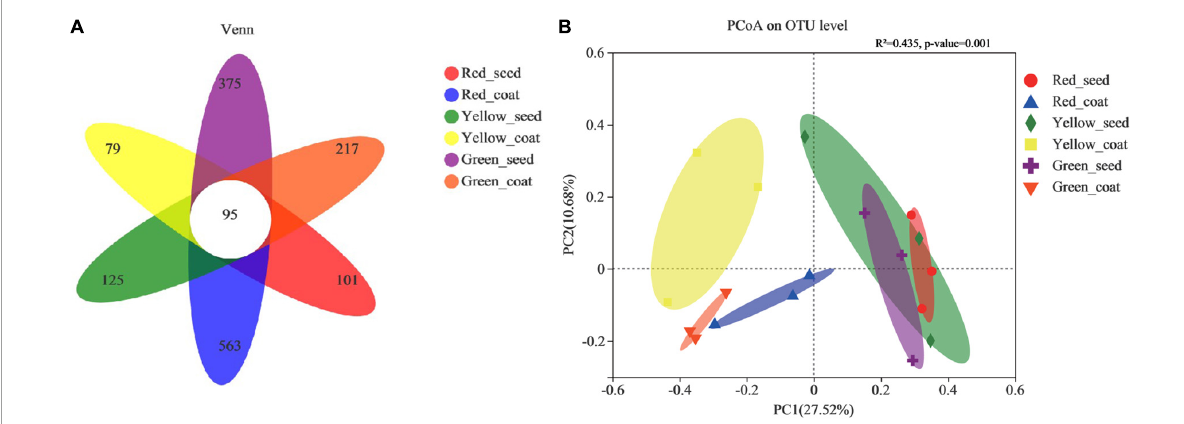
FIGURE2 Venn diagram showing the number of unique, shared, and common bacterial operational taxonomic units. (A) Principal coordinate analysis (PCoA) plots based on the Bray–Curtis dissimilarity matrix showing the changes in the structure of bacterial communities. (B) (PERMANOVA, R 2 = 0.435, p <